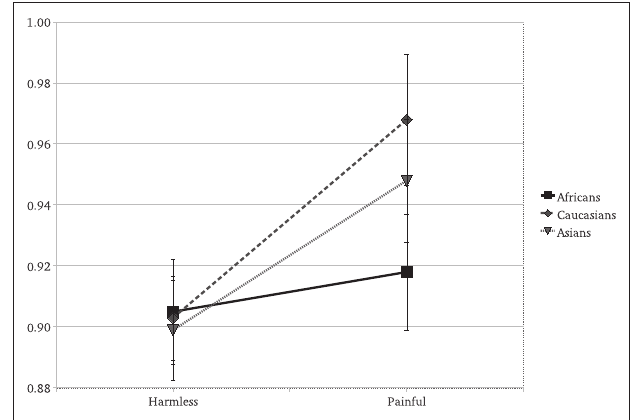
Figure 2 | experiment 2: SCr means as a function of stimulus type and the race of the person in